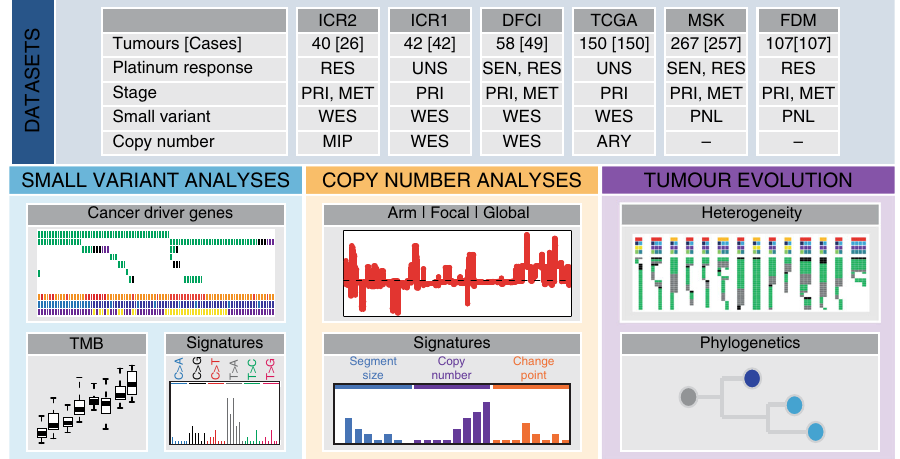
Fig. 1 Study overview. We combined data from six tumour sequencing studies of TGCT, performing small variant, copy number and tumour evolution analyses to de fi ne the molecular hallmarks of TGCT and their response to platinum-based therapies. RES: resistant, SEN: sensitive, UNS: unselected, PRI: primary, MET: metastasis, WES: whole exome sequencing, PNL: gene panel sequencing, MIP: molecular inversion probe, ARY: genotyping array, TMB: tumour mutation